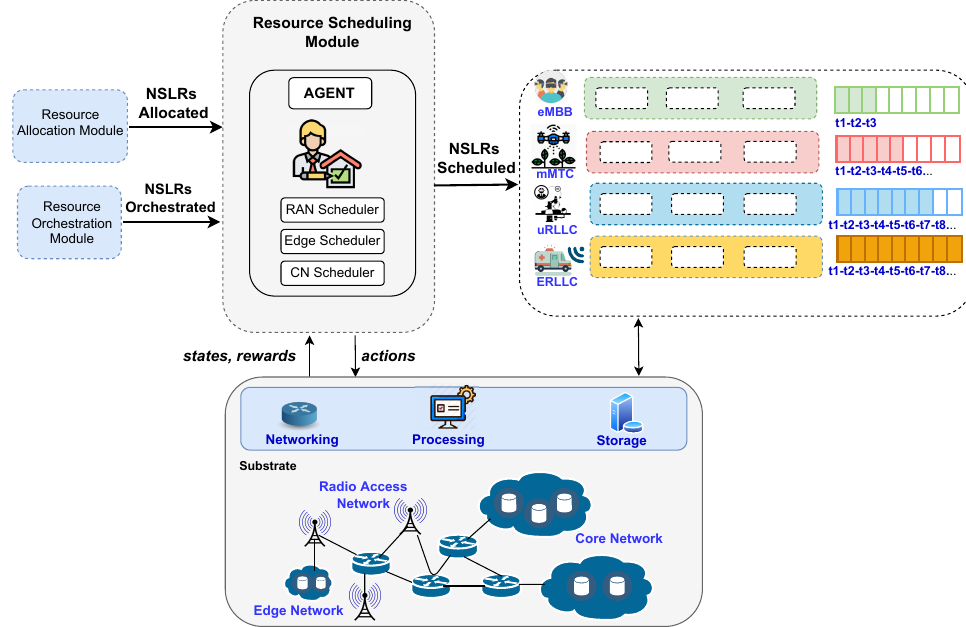
Figure 6. Resource scheduling architecture using